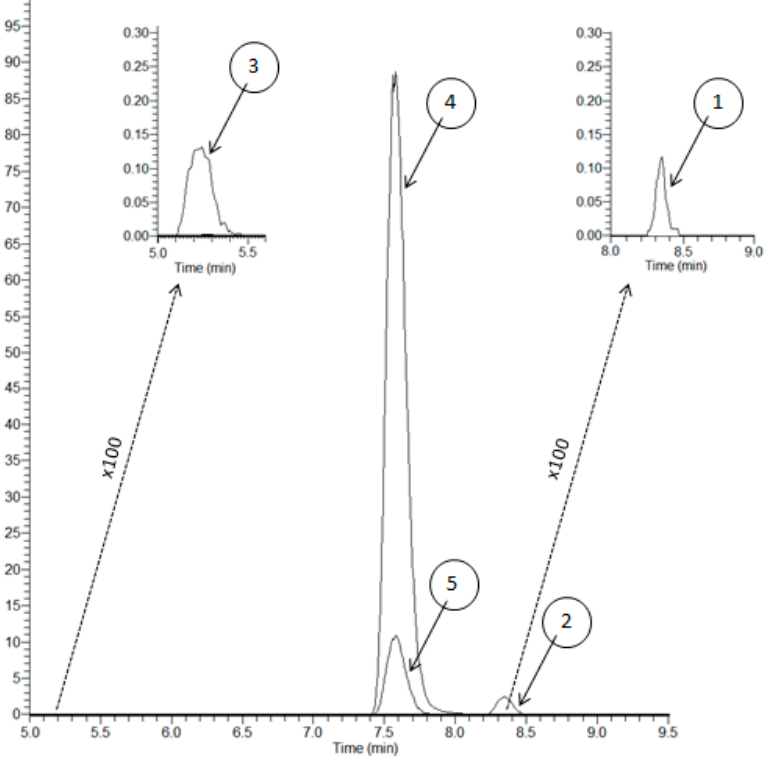
Figure 3. Chromatograms of the different forms of QVQLQQPGAELVK peptide after trypsin di- tion of a pure solution of rituximab. 1 (cid:13) : Wild type peptide: m/z = 719.4066 (charge: +2); 2 (cid:13) N-terminal gestion of a pure solution of rituximab. ① : Wild type peptide: m/z = 719.4066 (charge: +2); ② N- terminal Pyroglutamate (loss of NH 3 ): m/z = 710.8934 (charge: +2); ③ : Misscleavage (addition of Pyroglutamate (loss of NH 3 ): m/z = 710.8934 (charge: +2); 3 (cid:13) : Misscleavage (addition of PGASVK): PGASVK): m/z = 659.7091 (charge: +3); ④ : Misscleavage (addition of PGASVK) and N-terminal m/z = 659.7091 (charge: +3); 4 (cid:13) : Misscleavage (addition of PGASVK) and N-terminal pyroglutamate pyroglutamate (loss of NH 3 ): m/z = 980.5467 (charge: +2); ⑤ : Misscleavage (addition of PGASVK) (loss of NH 3 ): m/z = 980.5467 (charge: +2); 5 (cid:13) : Misscleavage (addition of PGASVK) and N-terminal and N-terminal pyroglutamate (loss of NH 3 ): m/z = 654.0336 (charge: +3). pyroglutamate (loss of NH 3 ): m/z = 654.0336 (charge: